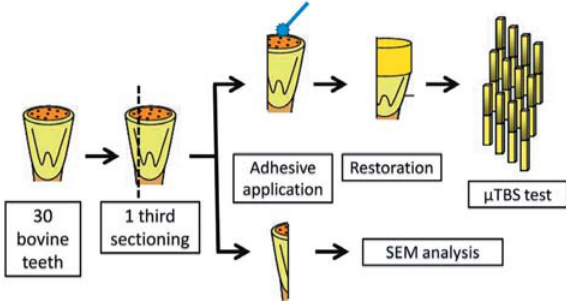
Figure 1- Flowchart of the micro-tensile bond